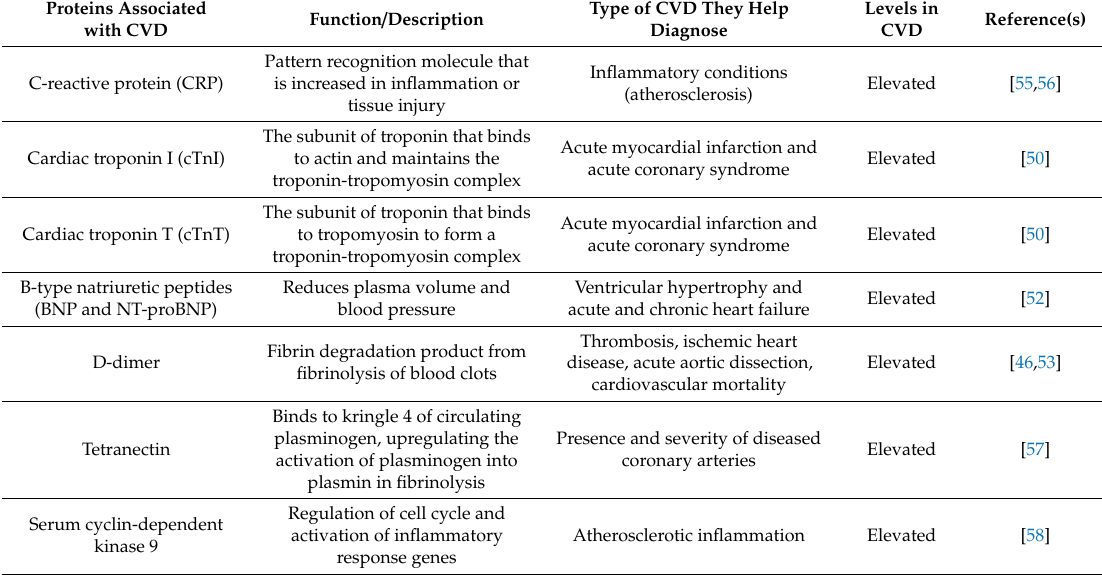
Table 1. Late stage protein biomarkers of cardiovascular